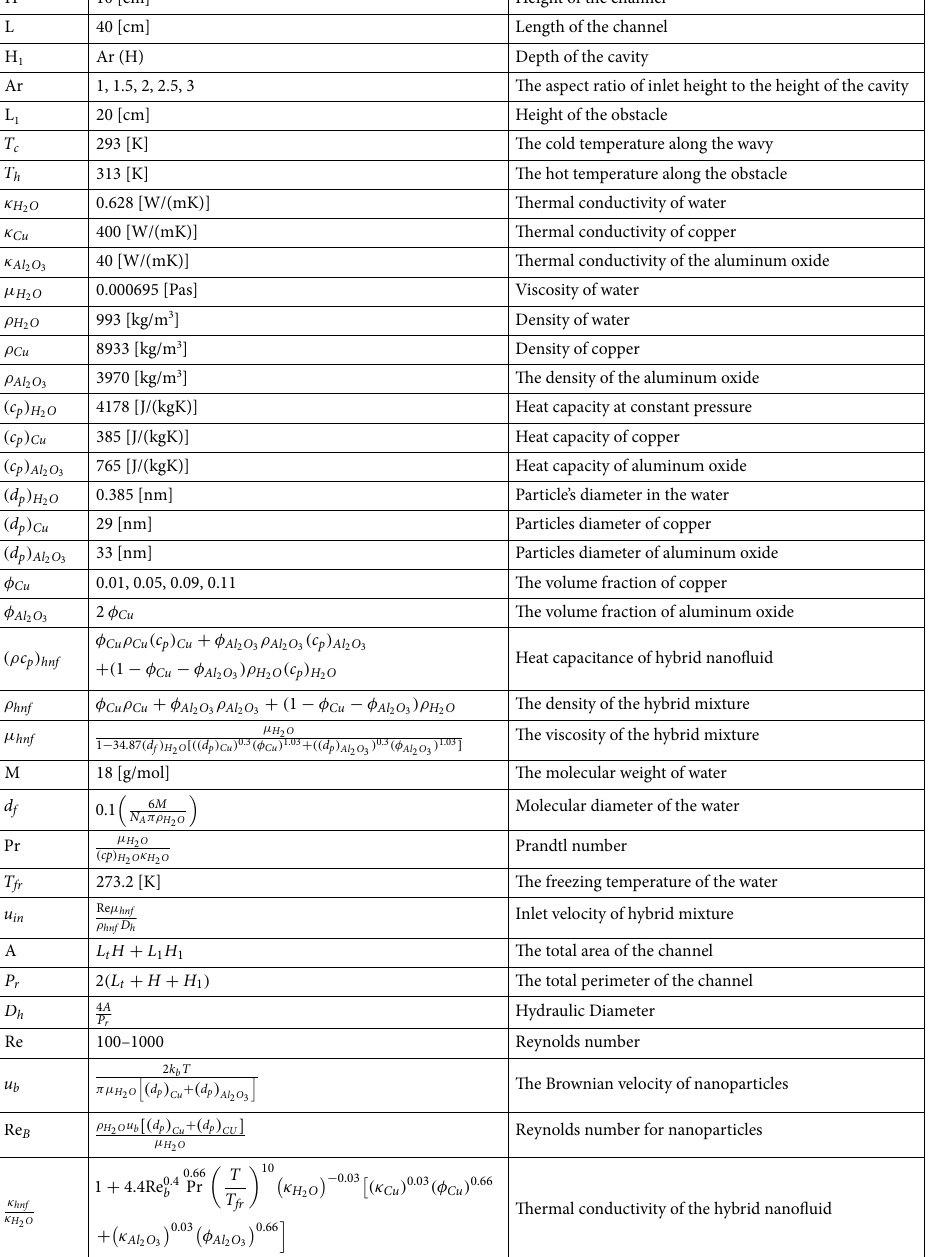
Table 1. Parameters and thermo-physical properties of the hybrid nanofluids 22